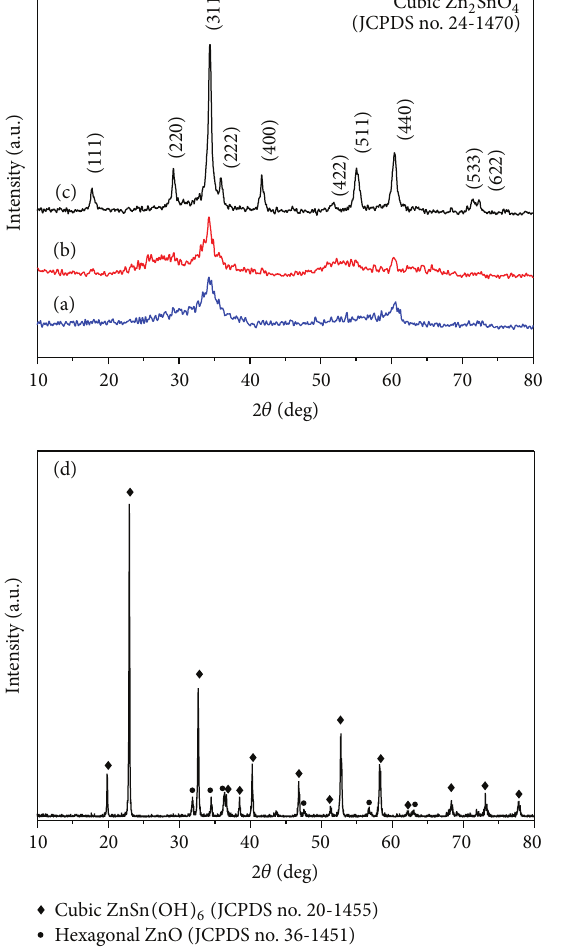
Figure 1: XRD patterns of the prepared samples (a) 4S, (b) 6S, (c) 8S, and (d) 10S.